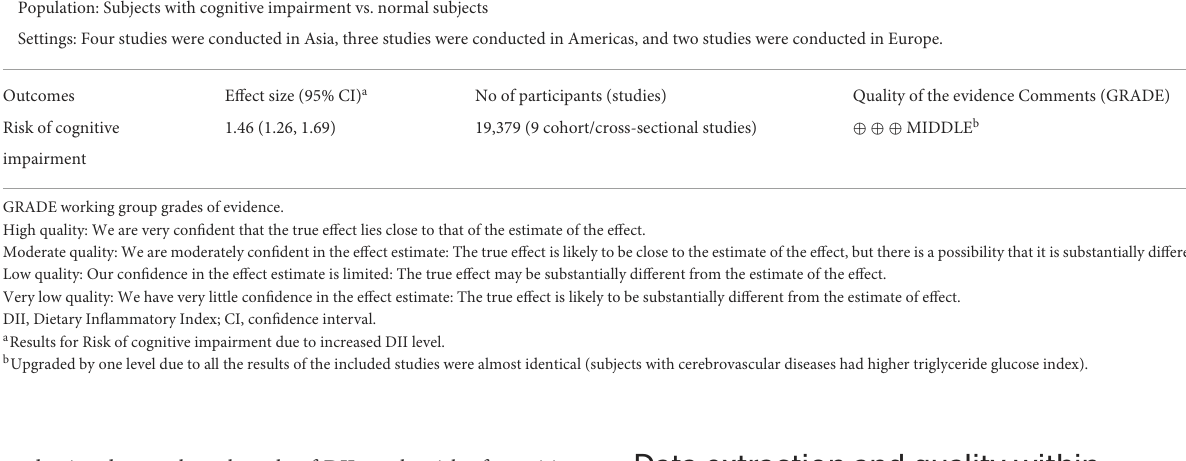
TABLE 2 The summary of findings (SoF) with GRADE system. The association between DII and cognitive